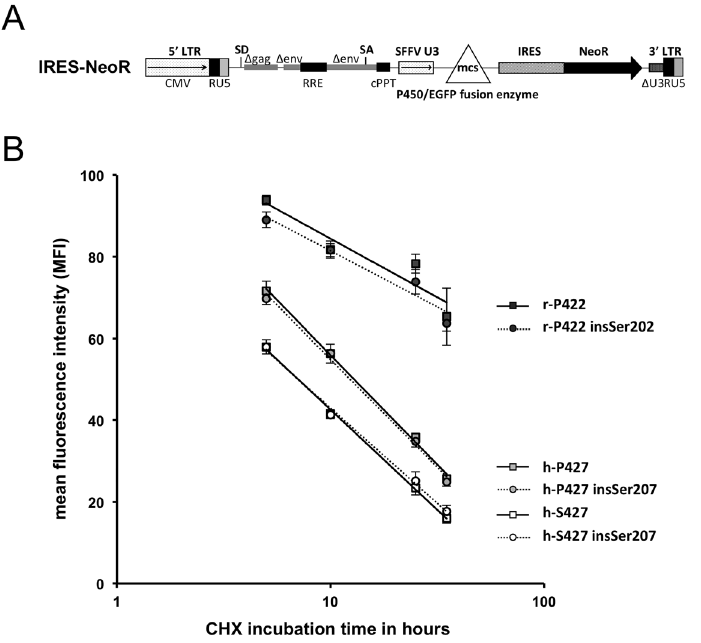
Fig 5. Protein stability of CYP4B1. (A) Schematic outline of the lentiviral vector used for expression of CYP4B1. CMV: CMV promoter; SD: splice donor; LTR: long terminal repeat; SA: splice acceptor; RRE: Rev responsive element, cPPT: central polypurine binding tract; SFFV U3: U3 promoter of the spleen focus- forming virus; mcs: multicloning site; IRES: internal ribosomal entry site; neoR: neomycin phosphotransferase (nptII) resistance cDNA; EGFP: enhanced green fluorescent protein. (B) Protein half-life analysis of CYP4B1 isoforms in HepG2 cells. Protein half-life analysis was performed by adding 50 μ g/ml cycloheximide (CHX) to the transduced and G418-selected HepG2 cells. The mean fluorescence intensity (MFI) of CYP4B1/EGFP fusion proteins was assessed at various time points by flow cytometry. For each construct, the mean ± SEM values are shown from at least three